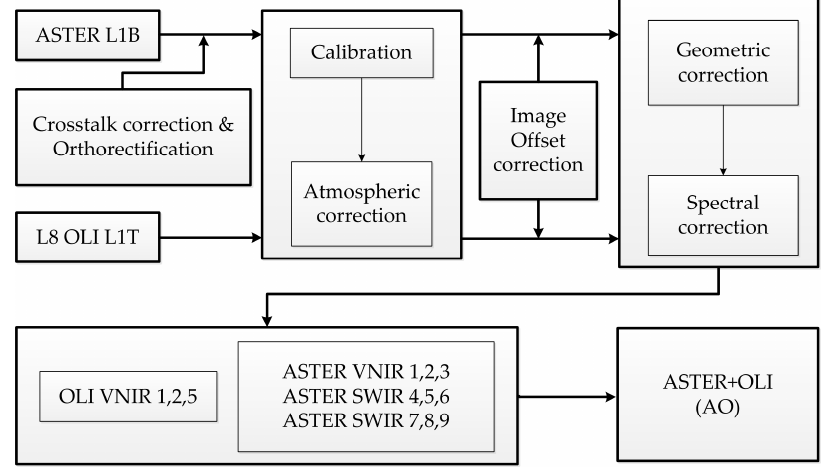
Figure 2. ASTER and L8-OLI pre-processing steps and AO integrating processing flowchart.